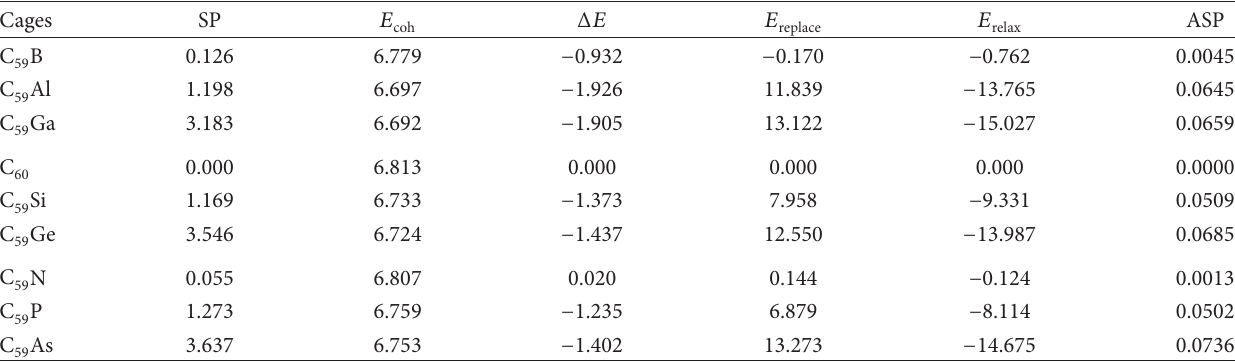
and the doped cages. (SP in GHz 60